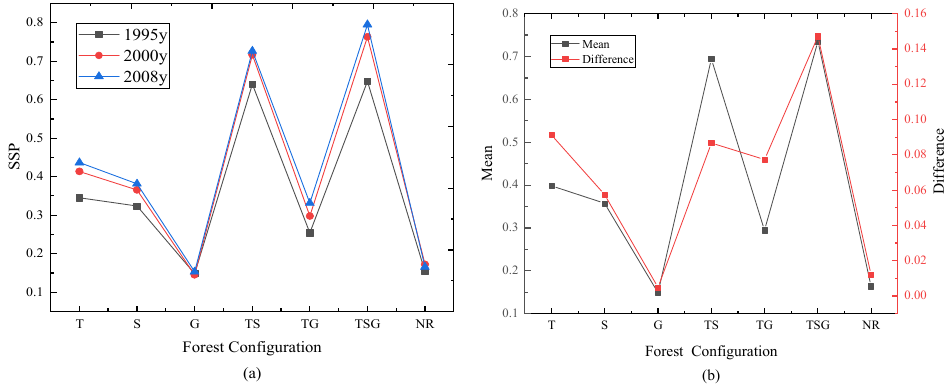
Figure 6. ( a ) Spatial structural parameters (SSP) of each forest configuration type at different restoration years, and ( b ) evaluation of forest spatial structure variability by means and differences. Note: T, tree; S, shrub; G, grass; TS, tree–shrub; TG, tree–grass; TSG, tree–shrub–grass.